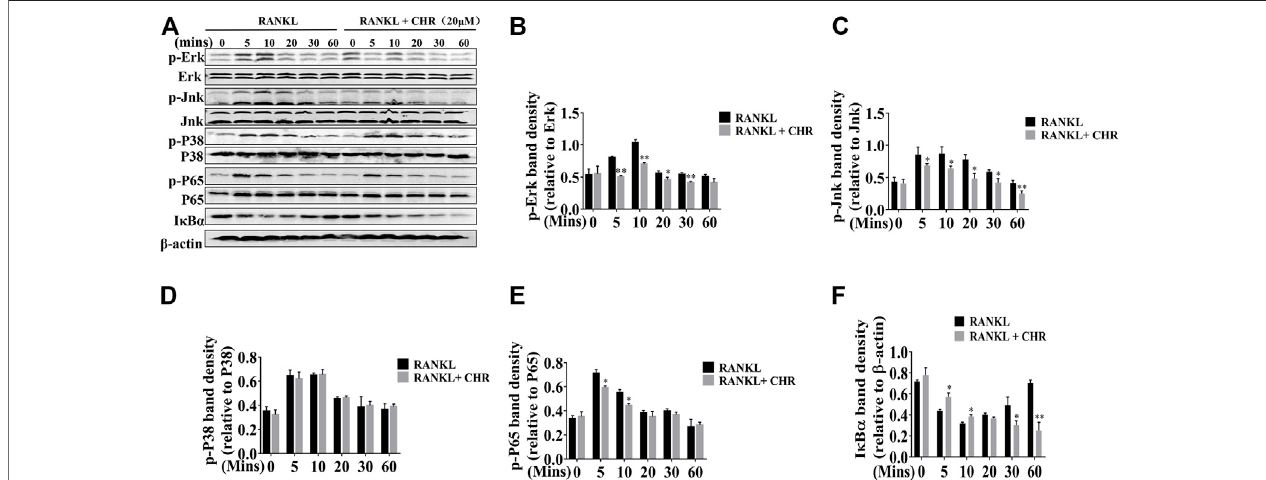
FIGURE 4 | CHR inhibited RANKL-induced MAPKs and NF- κ B signaling pathways. (A) BMMs cells were pretreated with or without 20 μ M CHR for 4 h and stimulated with stimulation with 100 ng/ml RANKL for indicated times. Cells were lysed, total cellular proteins were extracted and subjected to Western blot analysis usingspeci fi cantibodiesagainstp-ERK,totalERK,p-JNK,totalJNK,p-p38,totalp38,p-p65,totalp65,p-I κ B α ,andI κ B α .Antibodyagainst β -actinwasusedasinternal loading control. The relative density of protein bands for (B) p-ERK/total ERK, (C) p-JNK/total JNK, (D) p-P38/total P38, (E) p-p65/total p65, and (F) I κ B α / β -actin was quanti fi ed using ImageJ (n = 3) (* p < 0.05, ** p < 0.01, *** p < 0.001).